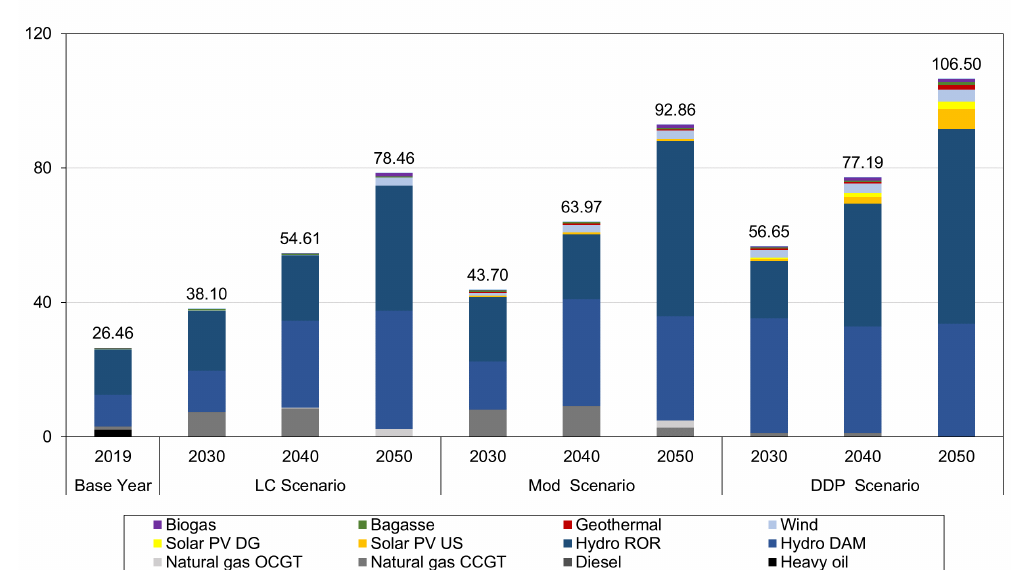
Figure 10. Power generation in TWh for the Ecuadorian power sector by 2019, 2030, 2040, and 2050 per